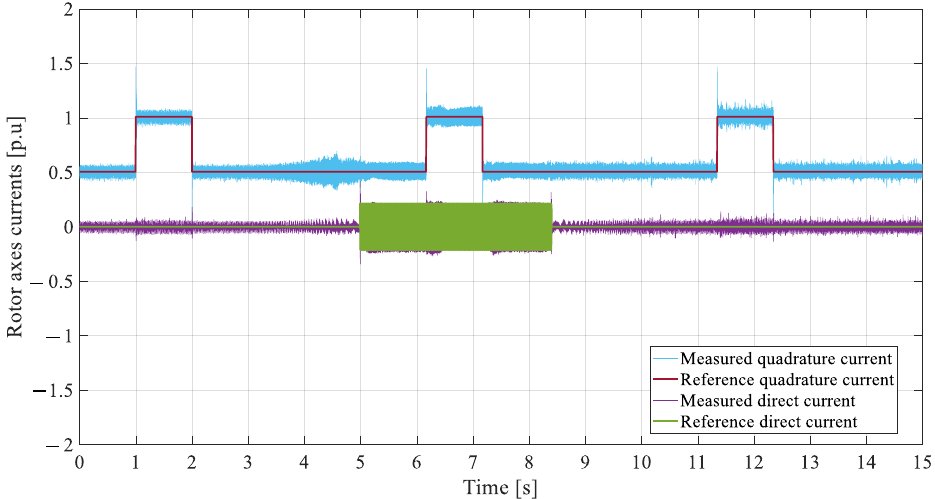
Figure 5. Behavior of the reference and actual rotor axes currents in the whole test.